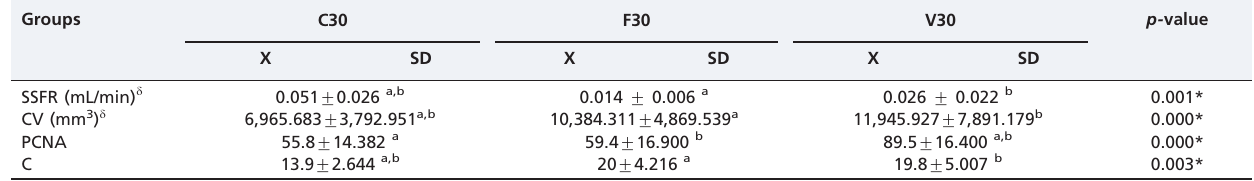
Table 2 - Mean values (X) and standard deviations (SD) of the studied variables in the groups treated for 30 days with saline (C30), fluoxetine (F30), or venlafaxine (V30).